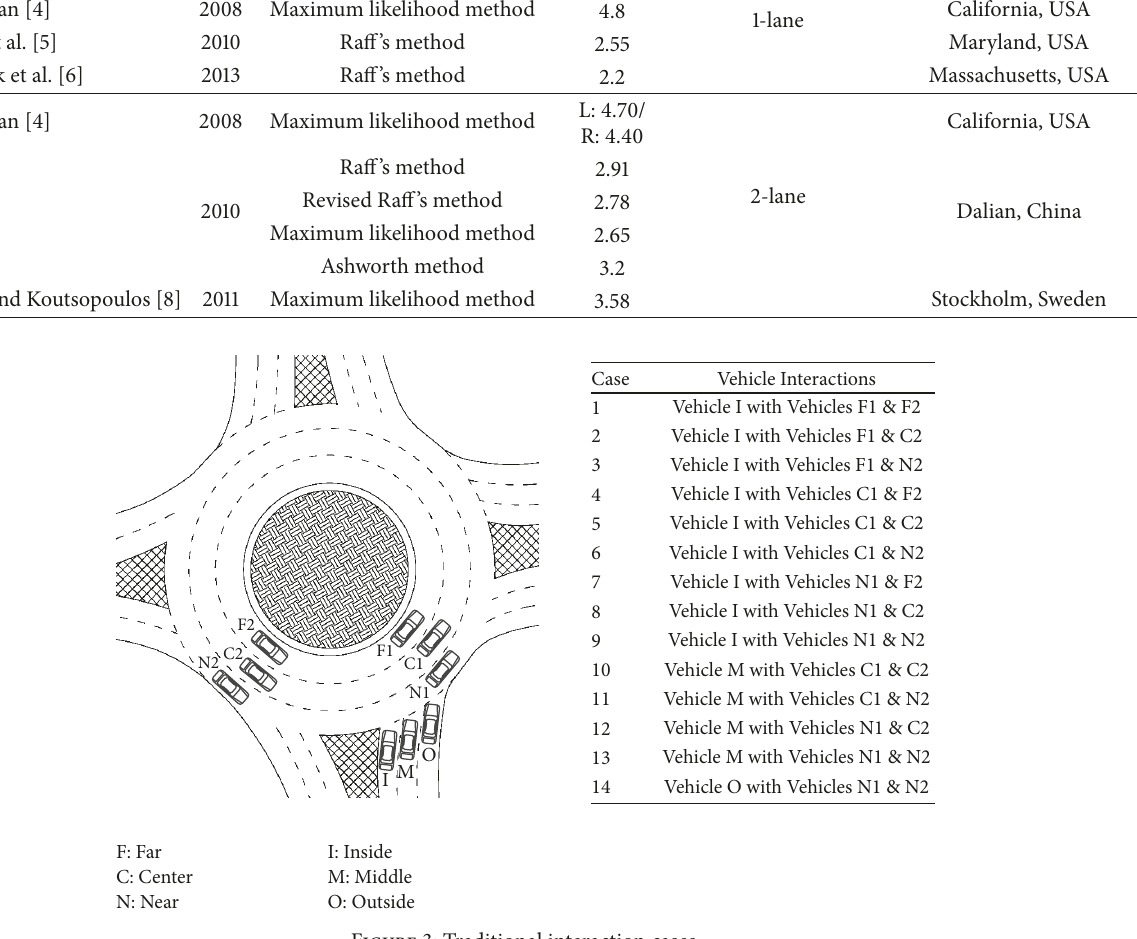
Figure 3: Traditional interaction